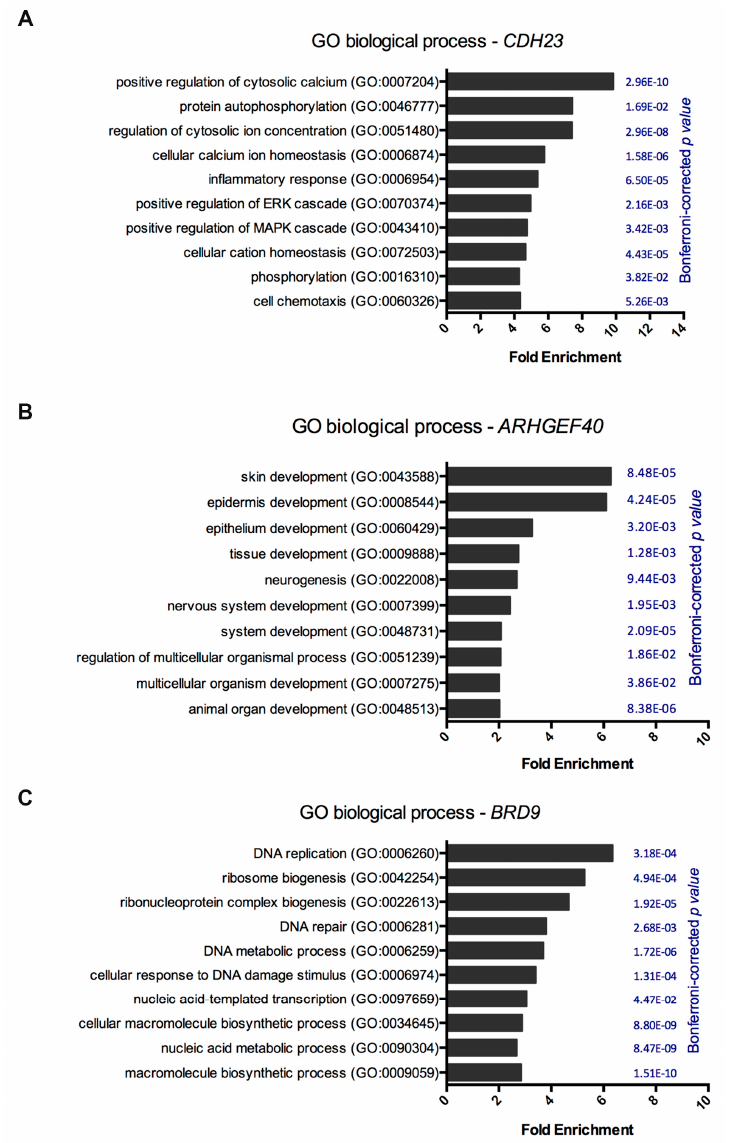
Figure 3. Gene ontology analysis of CDH23 , ARHGEF40, and BRD9 genes. Each gene expression was subjected to gene ontology and biological pathway enrichment analysis using PANTHER 14.0 against a Homo sapiens background reference. ( A ) Gene ontology and biological pathway enrichment for CDH23 expression, ( B ) ARHGEF40 expression, and ( C ) BRD9 expression. Statistical over-representation was calculated using a binomial test and the results were considered significant at p < 0.05, after Bonferroni correction.